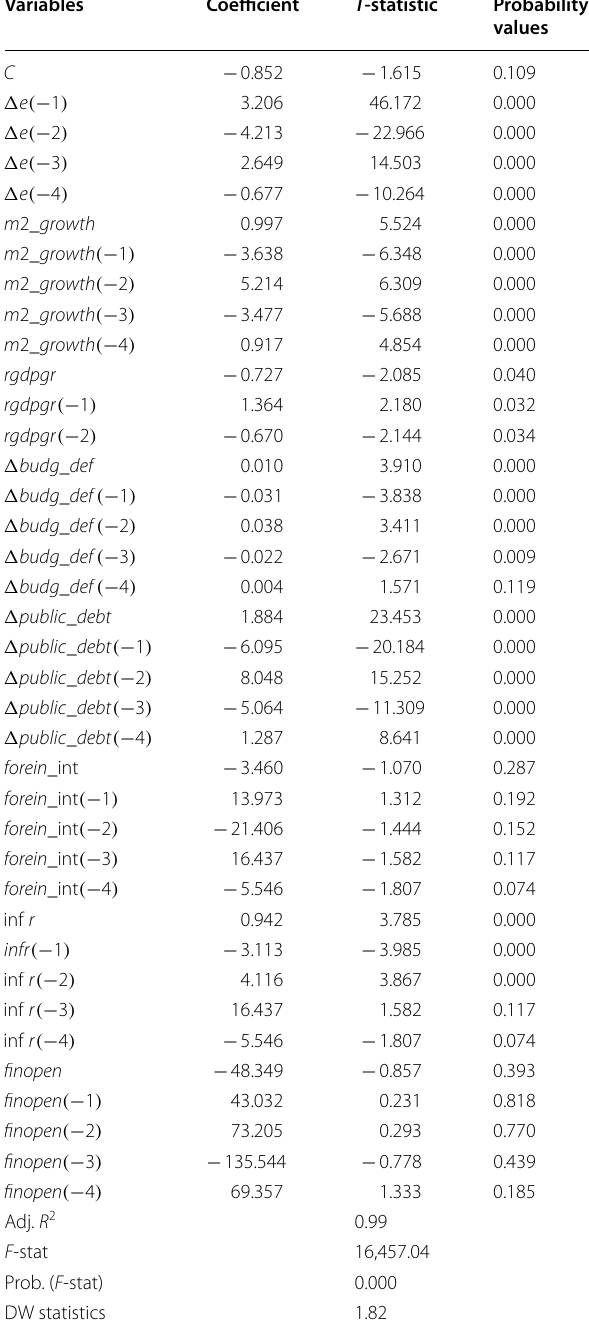
Table 5 Long-run dynamics. Source: E-views output